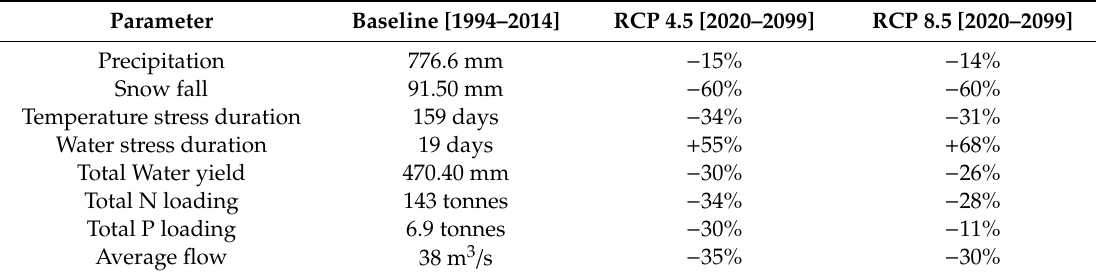
Table 5. Average parameter changes for the entire simulation